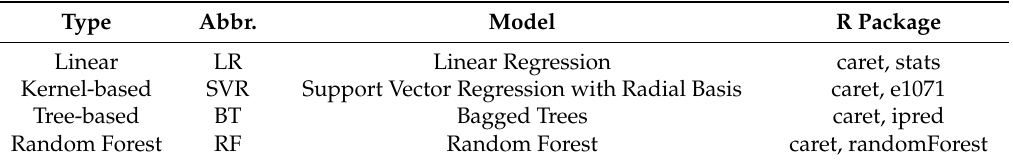
Table 4. Descriptions of the regression models used in this